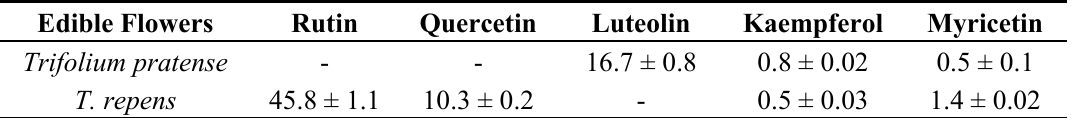
Table 1. Quantitative analysis by HPLC of selected flavonoids of Trifolium repens and T. pratense flowers